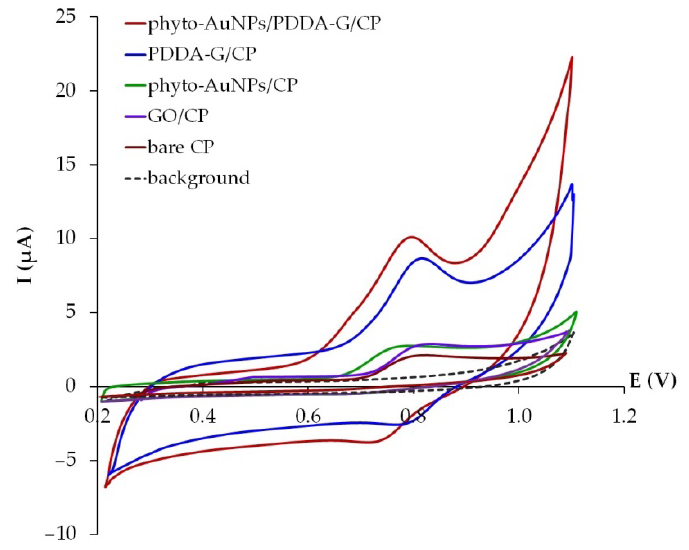
Figure 6. Cyclic voltammograms of 10 μM Ponceau 4R on different electrodes in the phosphate buffer solution ( рН 5), ν = 50 mV s − 1 .